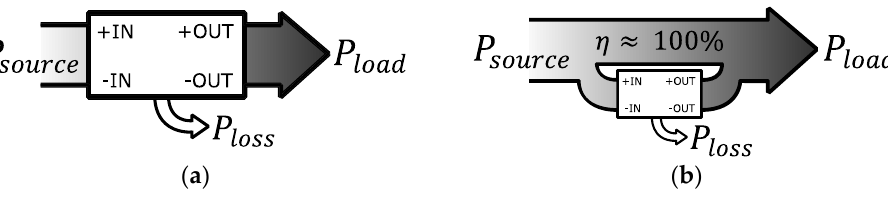
Figure 1. Power flow diagram. ( a ) FPP. ( b ) PPP.